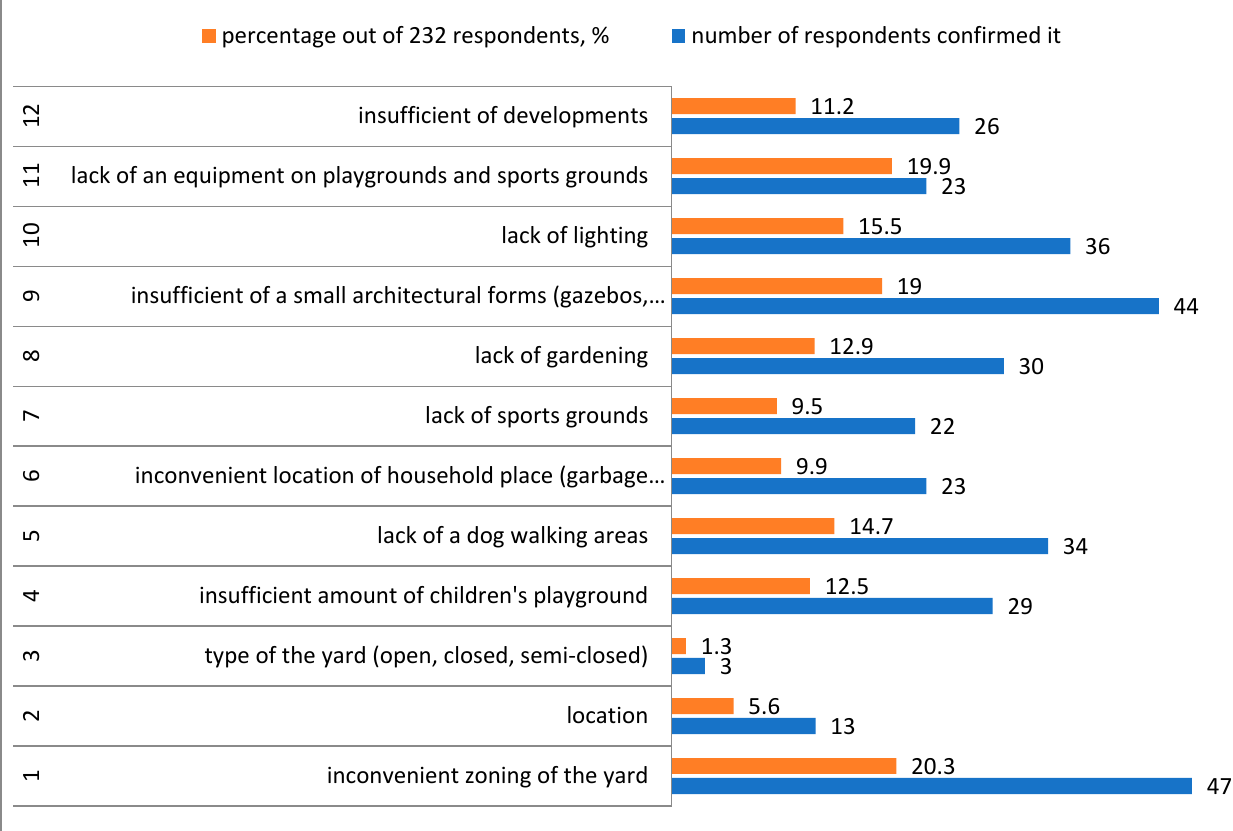
Figure 14. The results of the social survey (Author’s material).